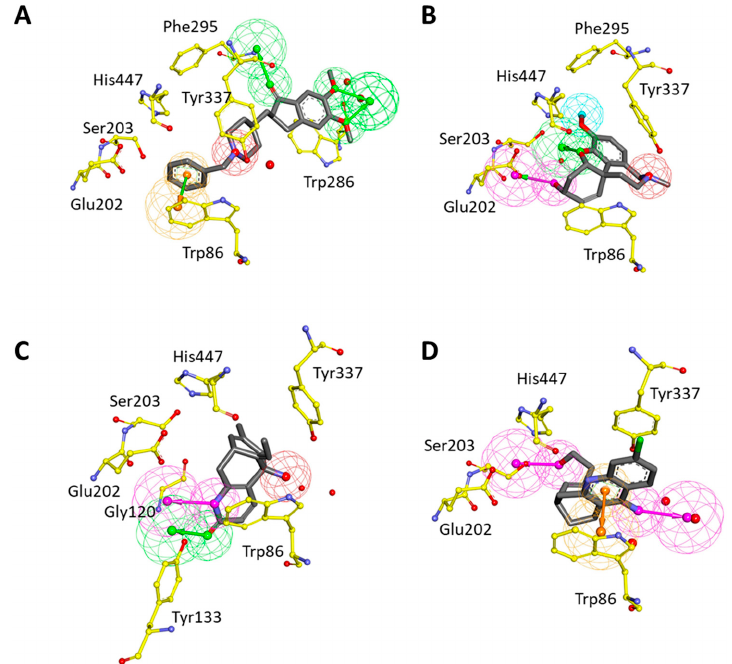
Figure 4. Structure-based pharmacophore models from hAChE-inhibitor complexes. Each model was generated from ( A ) donepezil (DNP), ( B ) galantamine (GNT), ( C ) huperzine A (HUP), and ( D ) huprine W (HUW) bound structure, respectively. The interacting residues of hAChE were displayed in yellow stick models. The pharmacophoric features, HBA (green), HY-AL (blue), HY-AR (cyan), RA (orange), and PI (red) were